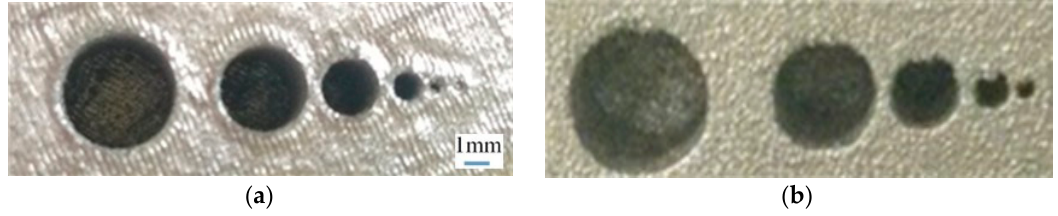
Figure 14. Small round holes fabrication experiments. ( a ) Fabricated round holes parallel to the Z axis; ( b ) Fabricated round holes vertical to the Z axis.